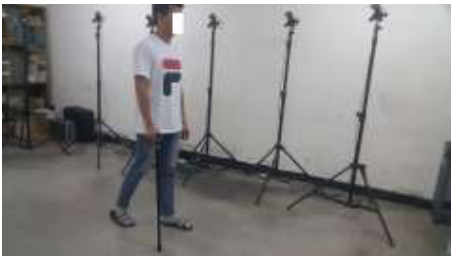
Figure 16. Acceleration norm and external acceleration.